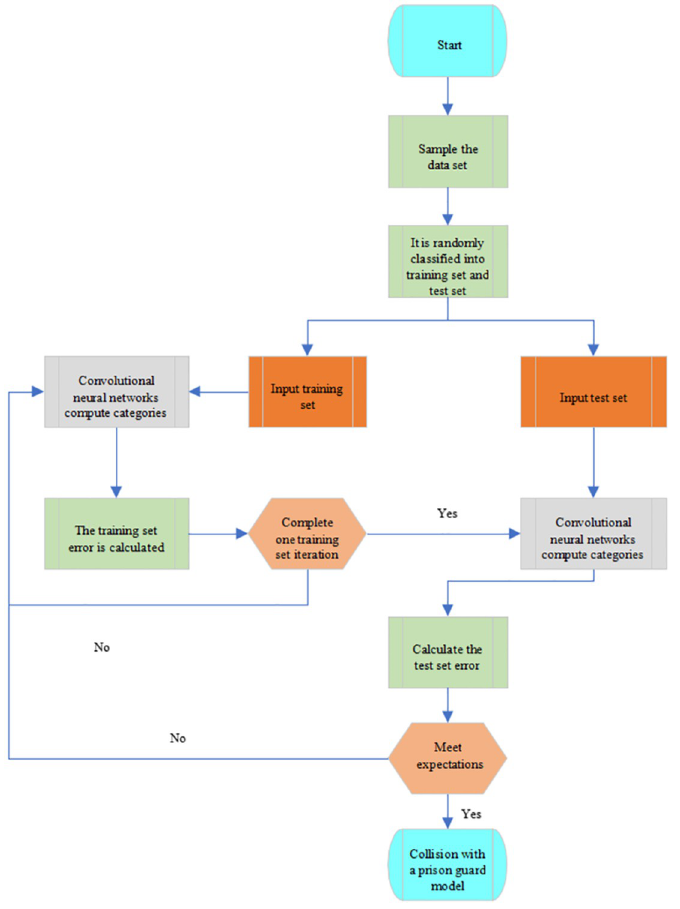
Fig 9. Flow of the CAW